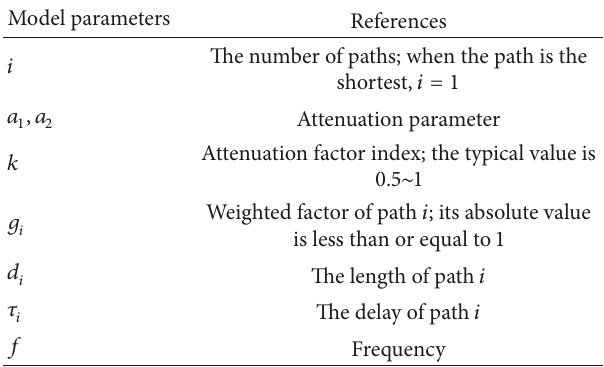
Table 1: Parameters of transfer function